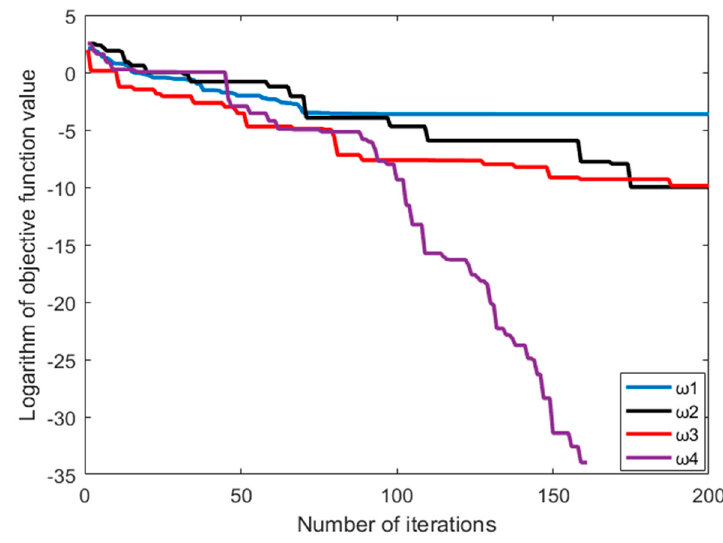
Figure 2. Iterative convergence curve from the Rastrigin function.